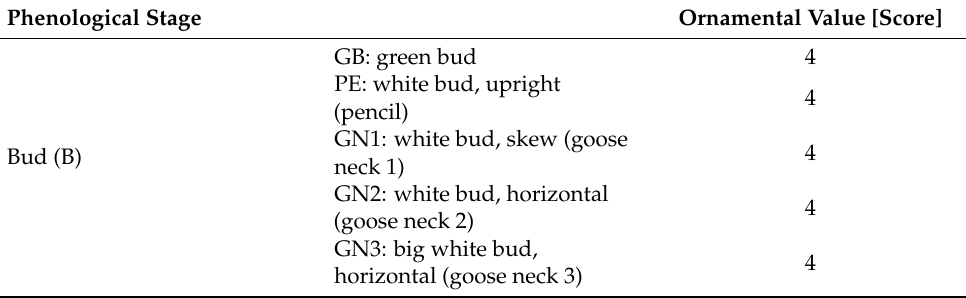
Table 1. Flower opening status categories and scores used to calculate the ornamental value. Phenological Stage